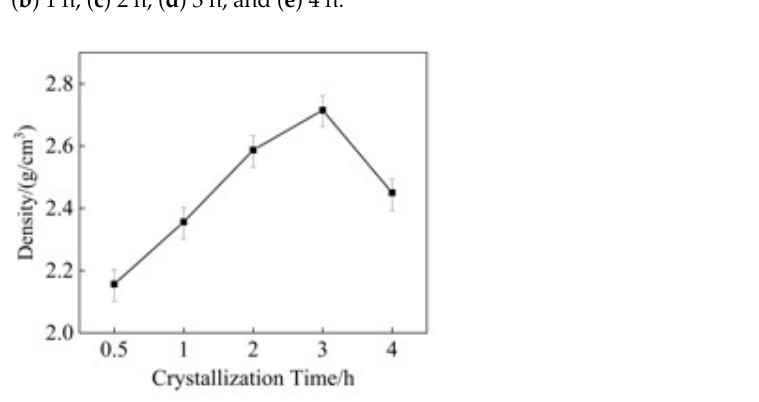
Figure 12. Effects of crystallization time on the density of microcrystalline glass.